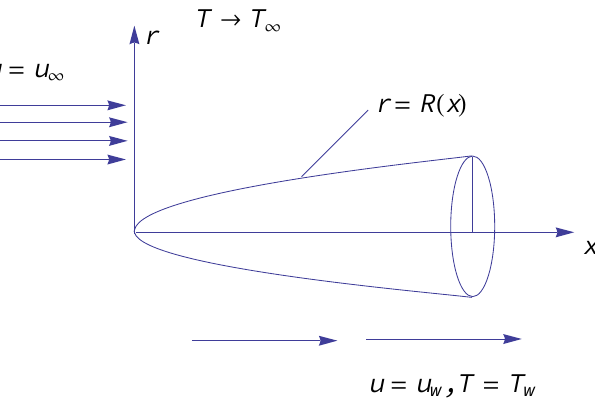
Figure 1. A schematic of the flow